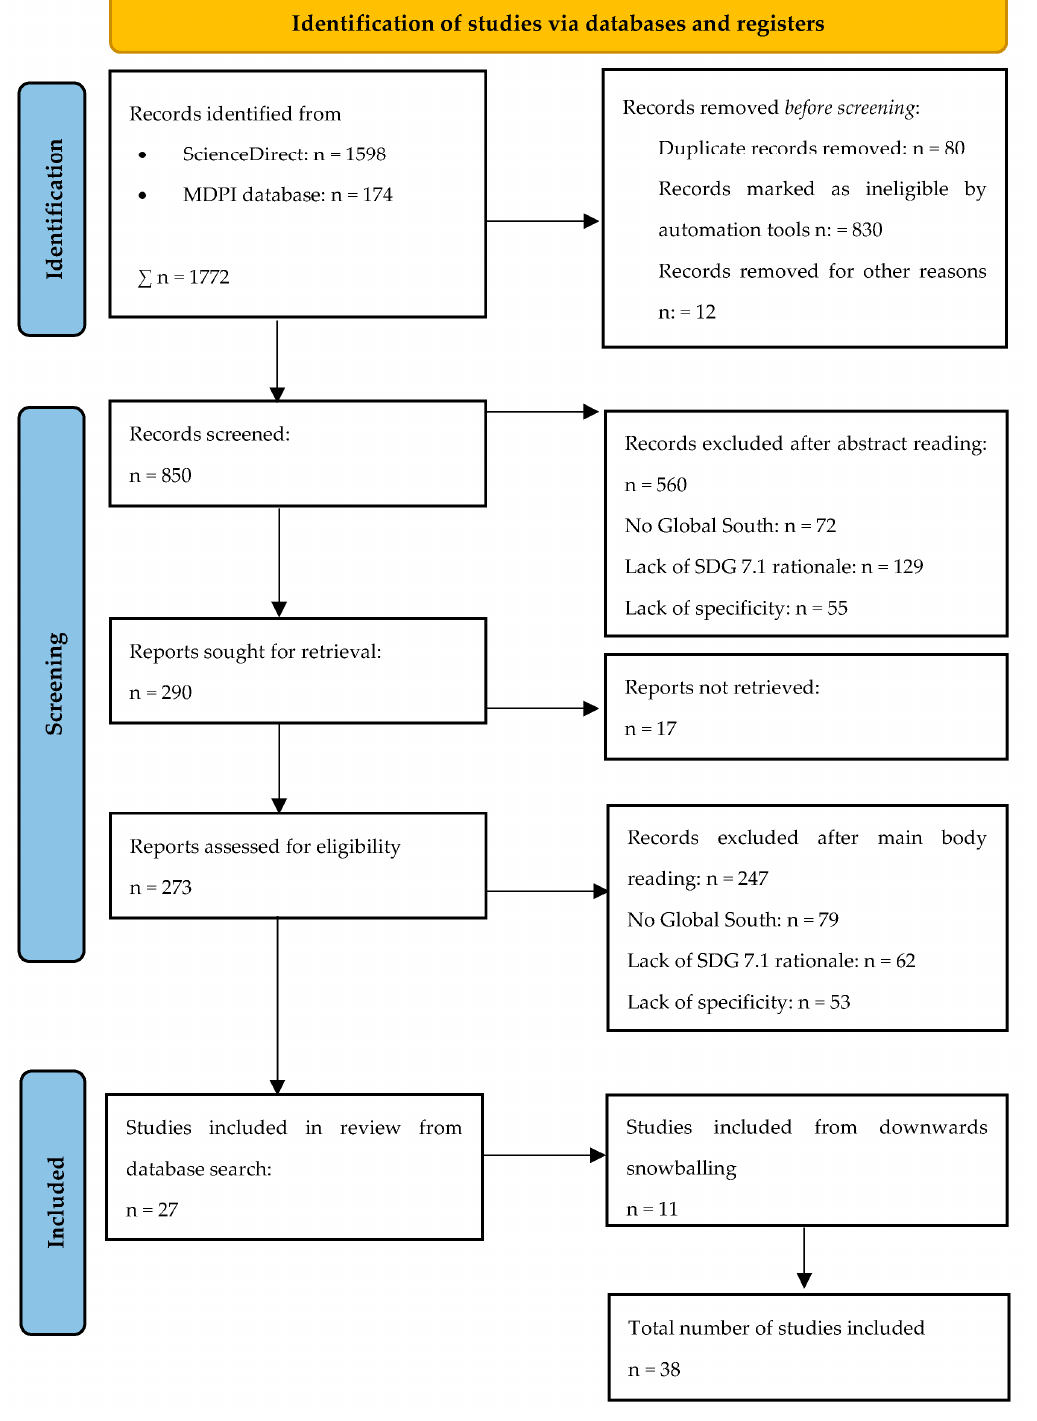
Figure A1. PRISMA 2020 flow diagram for new systematic reviews which included searches of databases, registers, and other sources [110]. Notably, during the initial search on “Hydrogen” + “off-grid” conducted in ScienceDirect, we cross-screened full texts to validate the methodology and exclusion criteria. This reduced the number of records screened for abstract reading only by approximately 50–90.